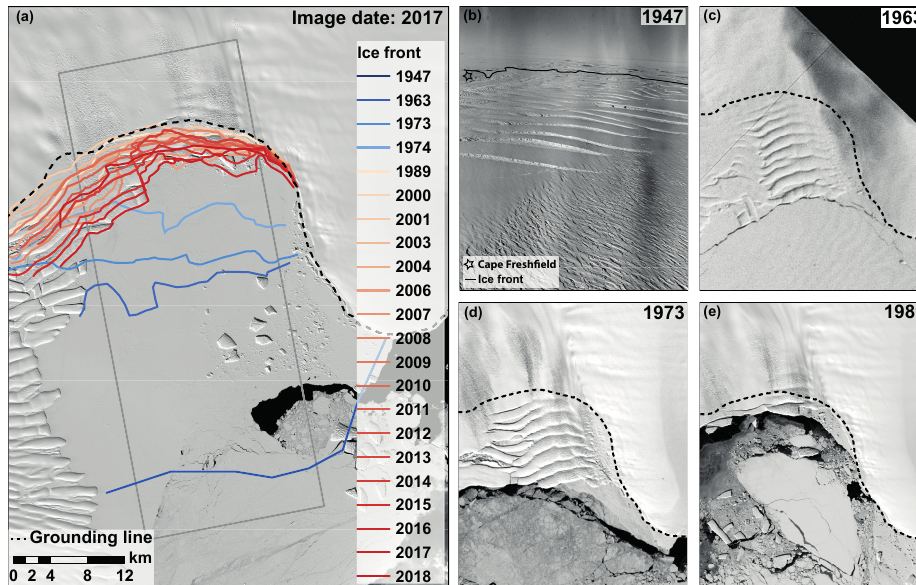
Figure 5. (a) Mapped ice front position of Cook West between 1947 and 2018. Note the exceptional retreat between 1947 and 1989. Grey box delineates the region where ice front position change was calculated. Grounding line is from Depoorter et al. (2013). (b–e) Images of Cook West Glacier in (b) 1947, (c) 1963, (d) 1973, and (e)